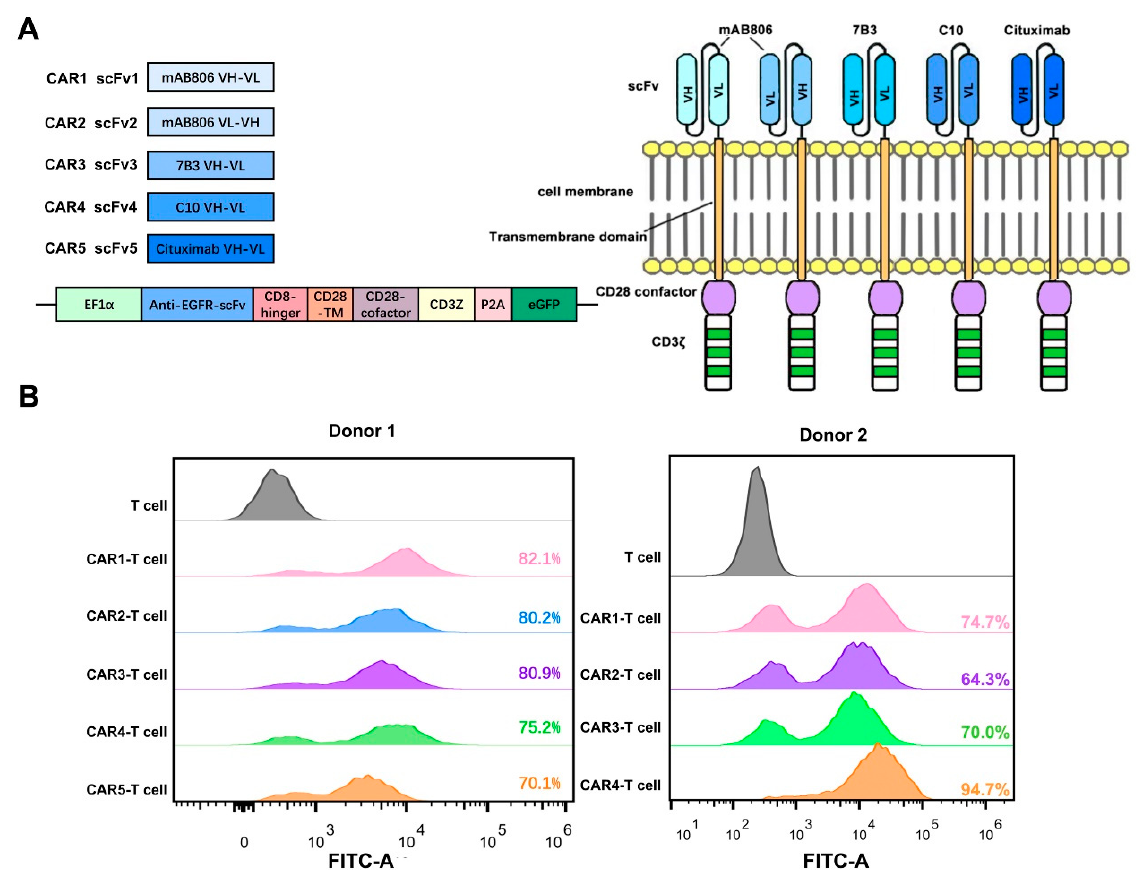
Figure 3. Design and expression of the anti-EGFR CAR. ( A ) Schematic illustration of the five second- generation anti-EGFR CAR constructs. ( Left ) Plasmid structure schematic, ( Right ) CAR structure schematic. ( B ) Expression levels of anti-EGFR CARs in T cells according to FACS analysis. T cells were isolated from PBMCs of two different donors.